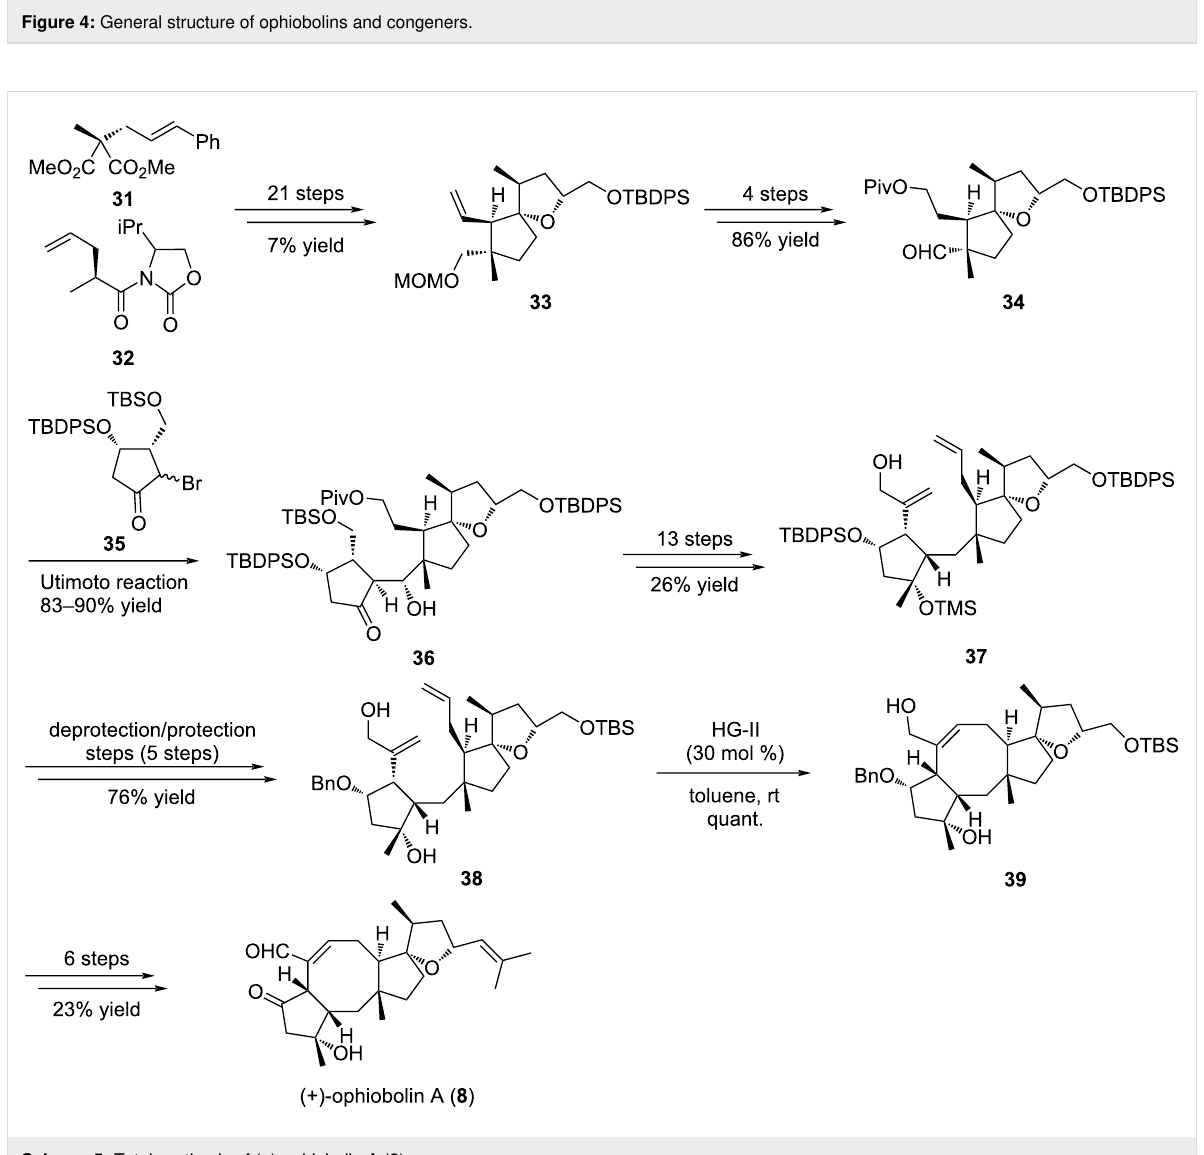
Scheme 5: Total synthesis of (+)-ophiobolin A ( 8